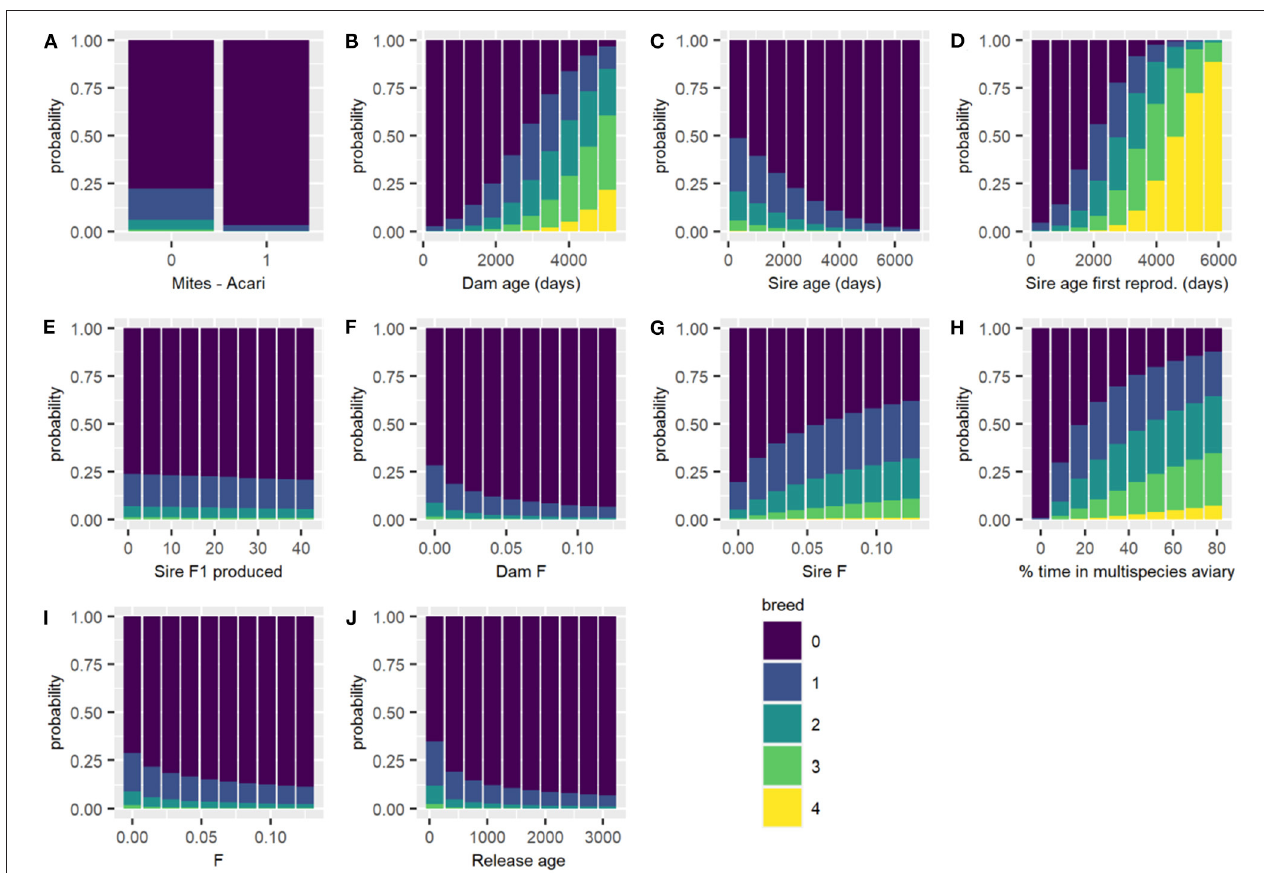
FIGURE 4 | Predicted probability of each breeding category for the subset of male birds that were resighted during breeding season for each breeding category changing each variable in turn, with all other continuous variables held at their mean and categorical variables held at their reference level. Breeding categories: (1) resighted but no nest, (2) nest, (3) incubation, (4) hatching, and (5) fledging success. (A) Mites - Acari; (B) Dam age (days); (C) Sire age (days); (D) Sire age at first reproduction (days); (E) Sire F1 produced; (F) Dam F; (G) Sire F; (H) percentage of time in multispecies aviary; (I) F inbreeding coefficient; and (J) Release age